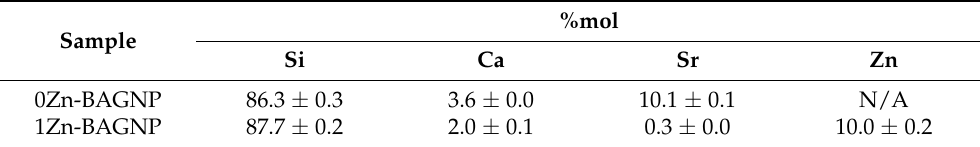
Table 3. Elemental composition of 0Zn-BAGNP with the one-step post-functionalisation process. Sample